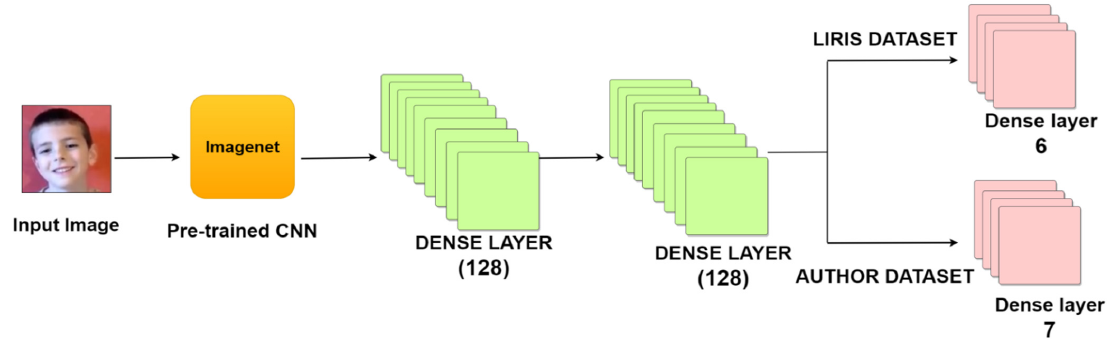
Figure 7. Proposed CNN structure